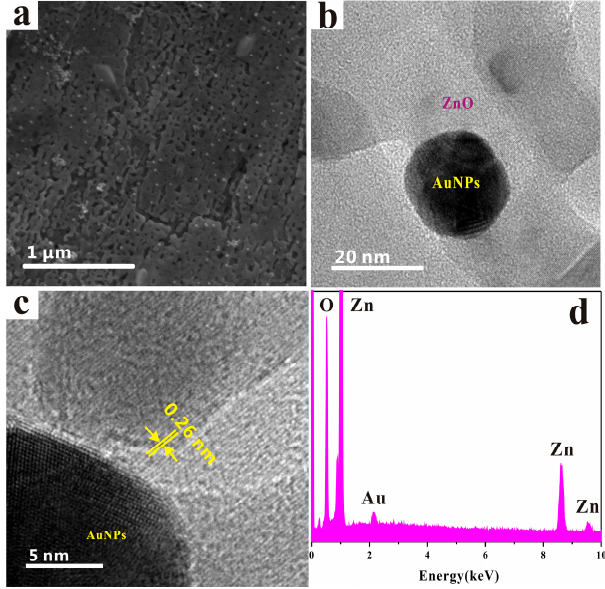
Figure 4. ( a ) SEM image, ( b ) TEM image, ( c ) lattice-resolved high-resolution transmission electron microscopy (HRTEM) image and ( d ) energy dispersive spectroscopy (EDS) spectrum of the Au-modified HPSCZNs.